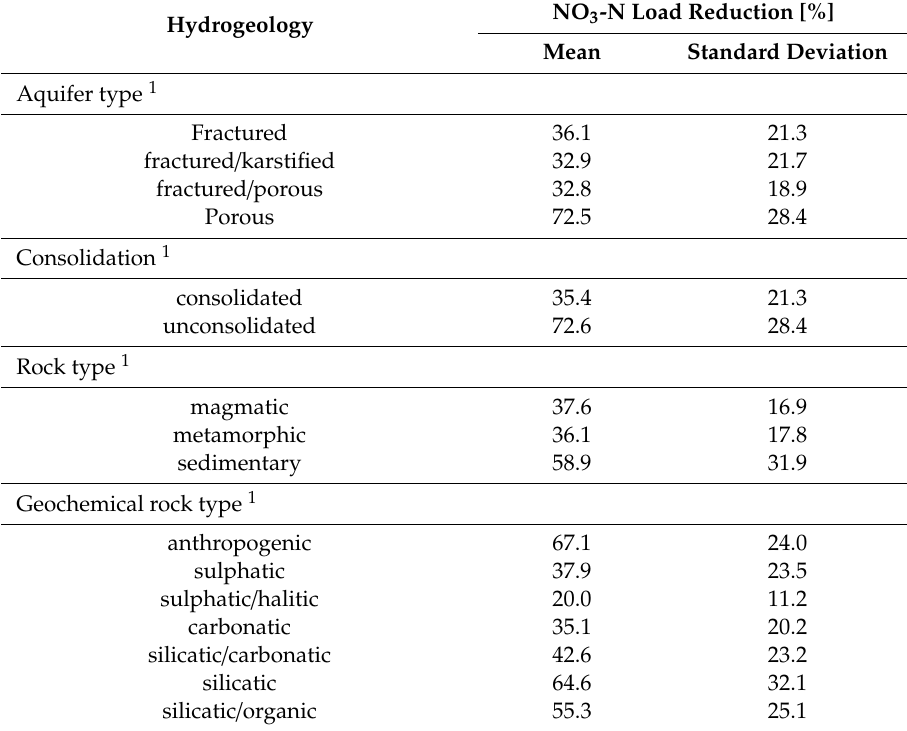
Mean NO 3 -N load reduction rates and standard deviation for the di ff erent hydrogeological